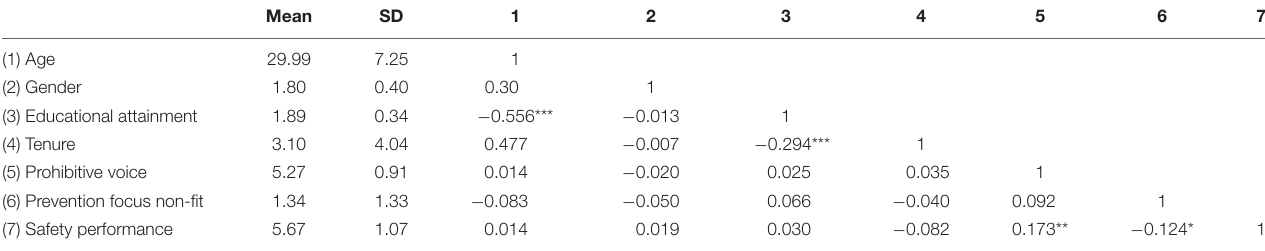
TABLE 3 | Means, standard deviations, and correlations of variables.